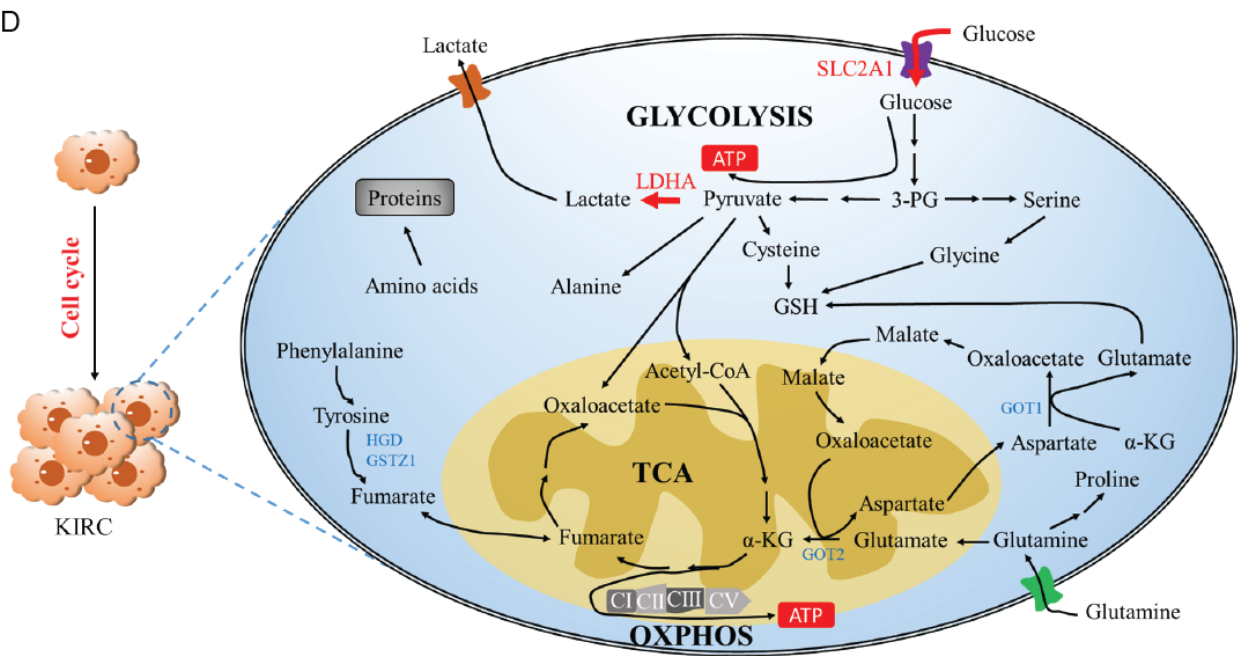
Figure 5. Down-regulation of HGD and GSTZ1 may serve as a potential diagnostic biomarker in KIRC. ( A ) The key regulator (HGD, GSTZ1, GOT1, and GOT2) mRNA expression levels between different grades of tumor and normal tissues in patients with KIRC in TGCA database. ( B ) Overall survival of patients with KIRC grouped by GOT1 and GOT2 expression through GEPIA web server. ( C ) ROC curve analysis indicated that the key regulator (HGD, GSTZ1, GOT1, and GOT2) could efficiently distinguish KIRC from normal individual. AUC, the area under curve. ( D ) Proposed model: The role and mechanism of HGD and GSTZ1 in KIRC progression.